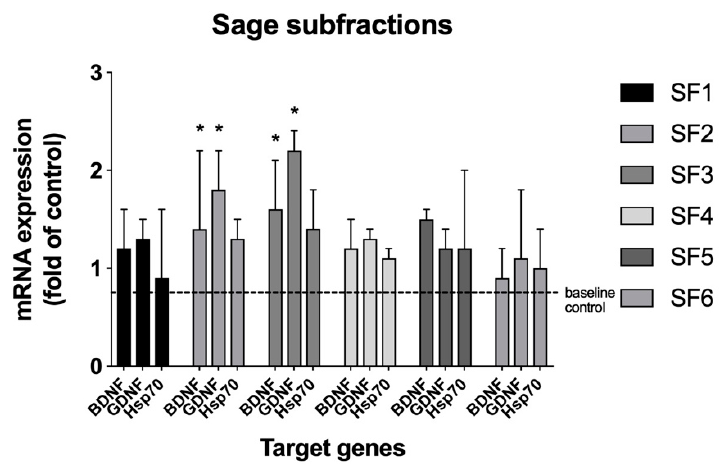
Figure 2. Sage RP-HPLC subfractions SF1 through SF6 modulation of neurotrophic factor mRNA levels in C6 glioma cells. Samples were screened at an initial concentration of 50 µ g/mL in triplicate. Results were expressed as a fold change of the control. * p < 0.05 versus vehicle control by Tukey's multiple comparison test.